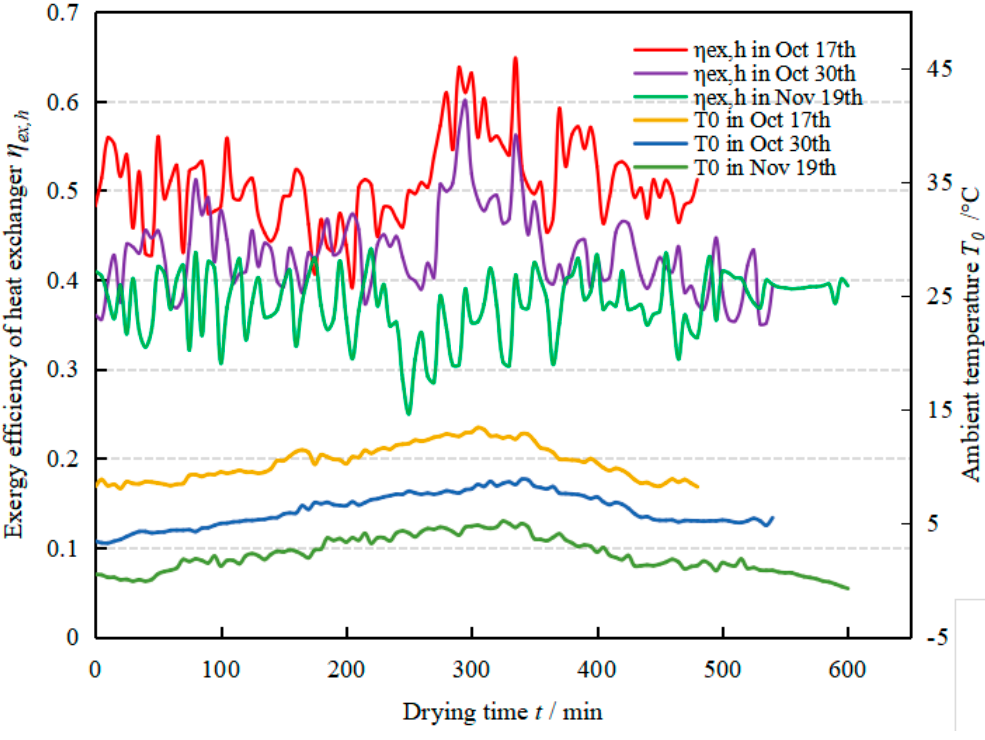
Figure 6. Variations of exergy efficiency of the heat exchanger and the ambient temperature with drying time.